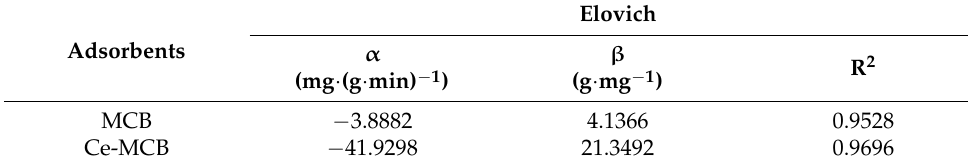
Table 4. The fitting parameters of